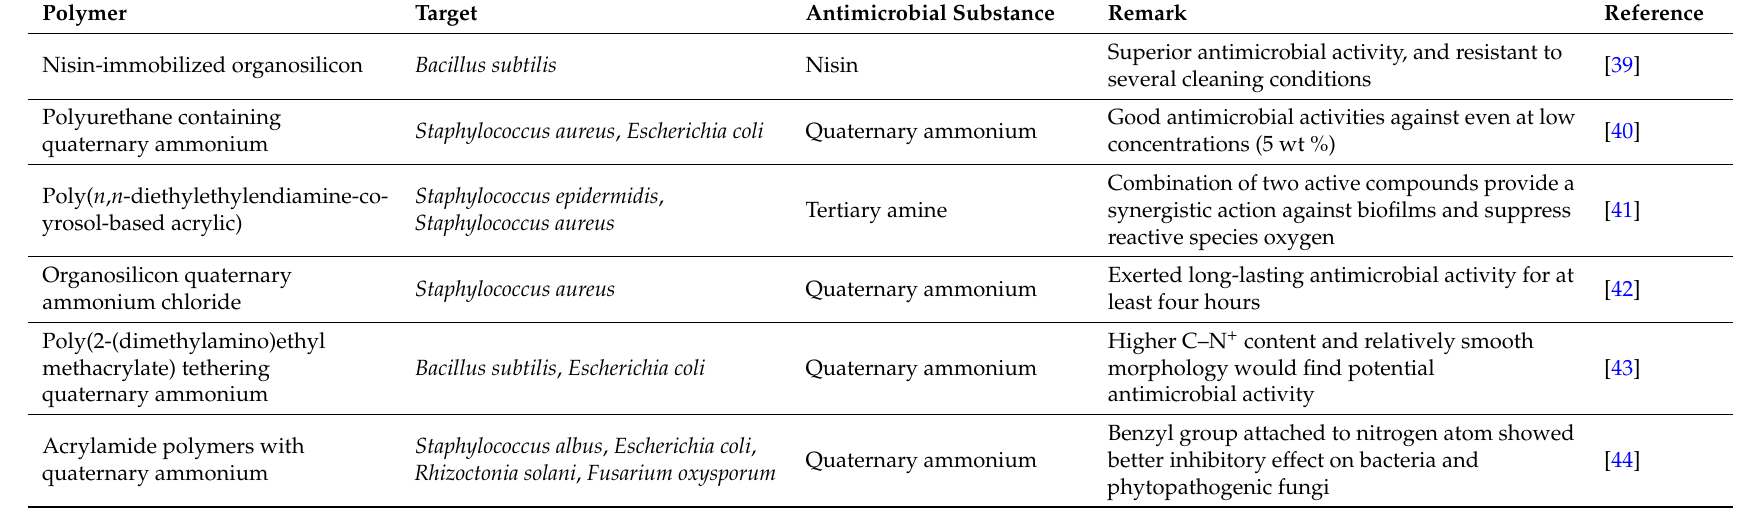
Table 3. Examples of active polymers for antimicrobial